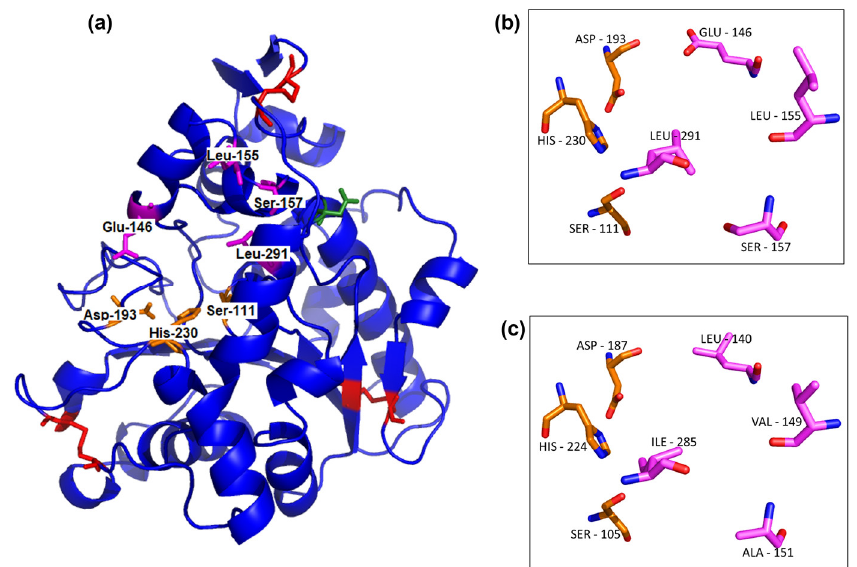
Figure 3. The UhL model was calculated by the SWISS-MODEL using CaLB (PDB number: 1TCA) as the template (Qmean = 0.16; GMQE = 0.92). Sticks in red are the disulfide bonds, in orange the catalytic triad (Ser111, Asp193, His230), in green the glycosylation site, and in pink the four amino acid differences between UhL and CaLB ( a ). The catalytic triad and four different amino acids in the active pocket are shown in detail for UhL model ( b ) and CaLB structure ( c ). The oxygen and nitrogen atoms are shown in red and blue, respectively, in panels ( b , c ).